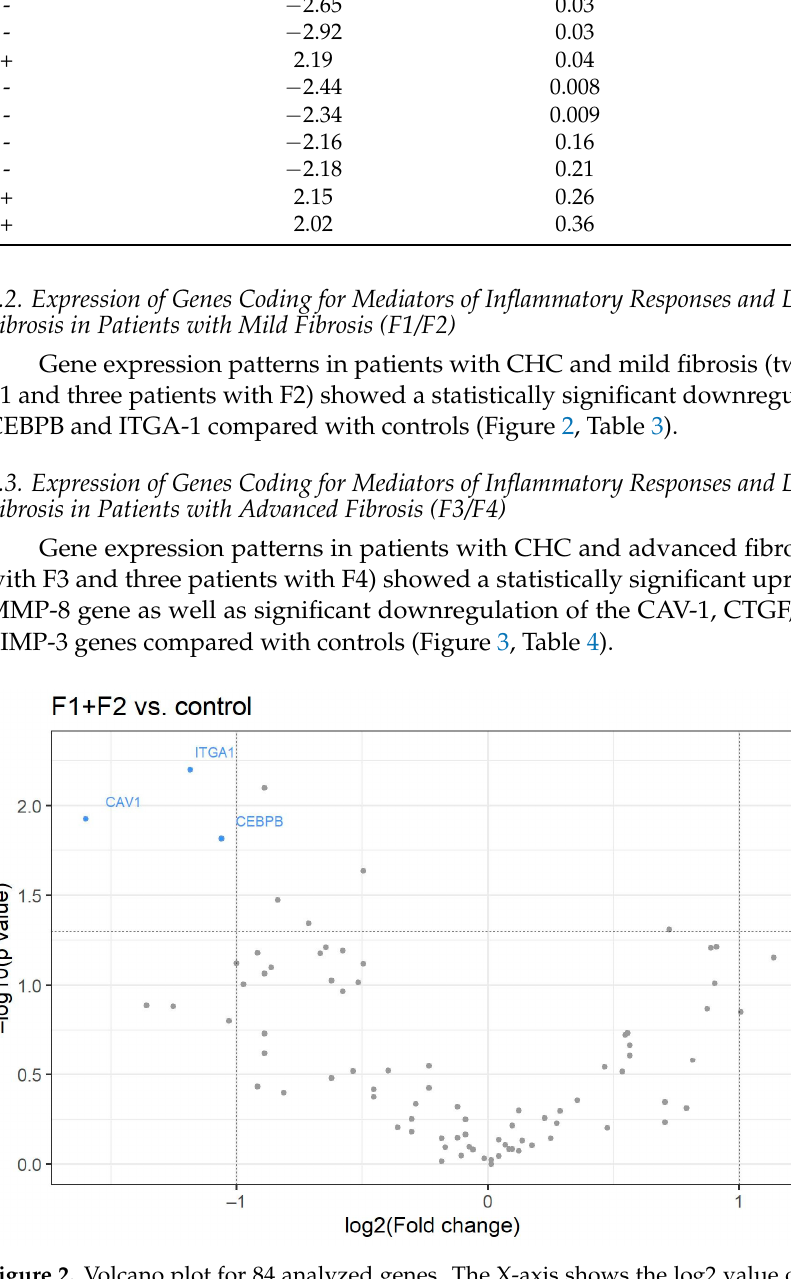
Figure 2. Volcano plot for 84 analyzed genes. The X-axis shows the log2 value of the fold change between patients with F1 and F2 stages of chronic hepatitis C compared to healthy controls without HCV. The Y-axis represents − log10 p -value. Red points symbolize overexpressed genes and blue points represent underexpressed genes. Horizontal line shows threshold where p = 0.05. Table 3. Gene expression patterns in patients with chronic hepatitis C with mild fibrosis (F1/2) and controls. P-values were corrected for multiple testing with Benjamini–Hochberg method.